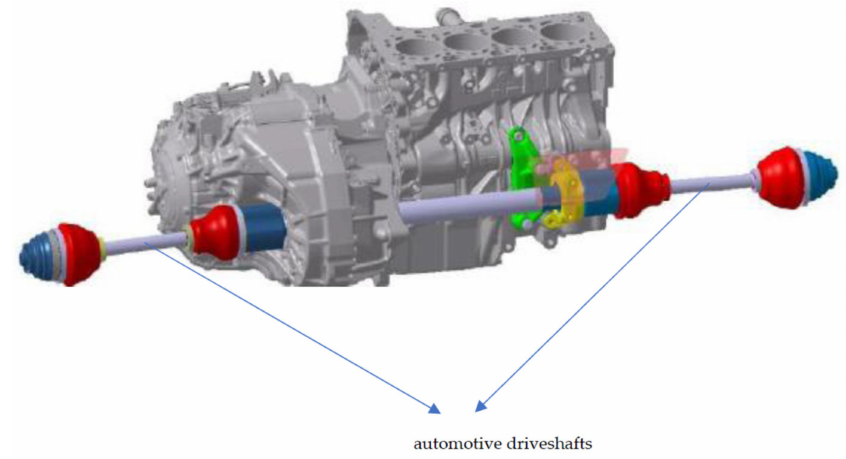
Figure 1. The ADs are mounted in the gearbox.